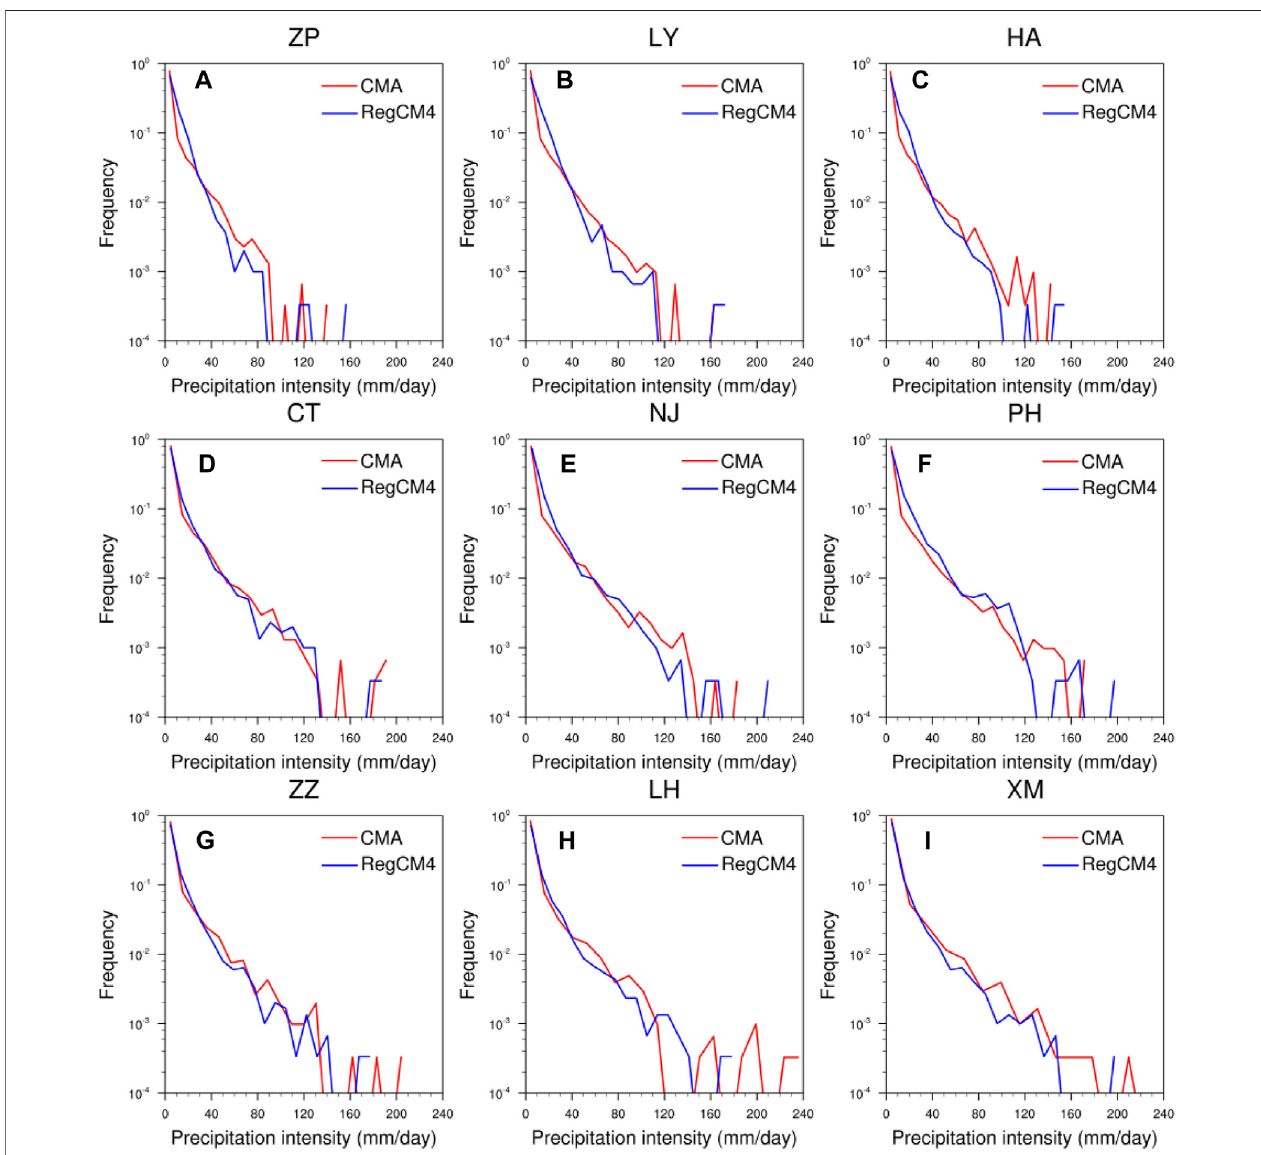
FIGURE 3 | Frequency distributions of daily precipitation intensity (mm/day) calculated at (A) Zhangping, (B) Longyan, (C) Huaan, (D) Changtai, (E ) Nanjing, (F) Pinghe, (G) Zhangzhou, (H) Longhai,and (I) Xiamenmeteorologicalstationsfortheentirerainyseasonduring1986 – 2005.Theredlinesindicatetheobservation,andthe blue lines are for RegCM4 simulation driven by